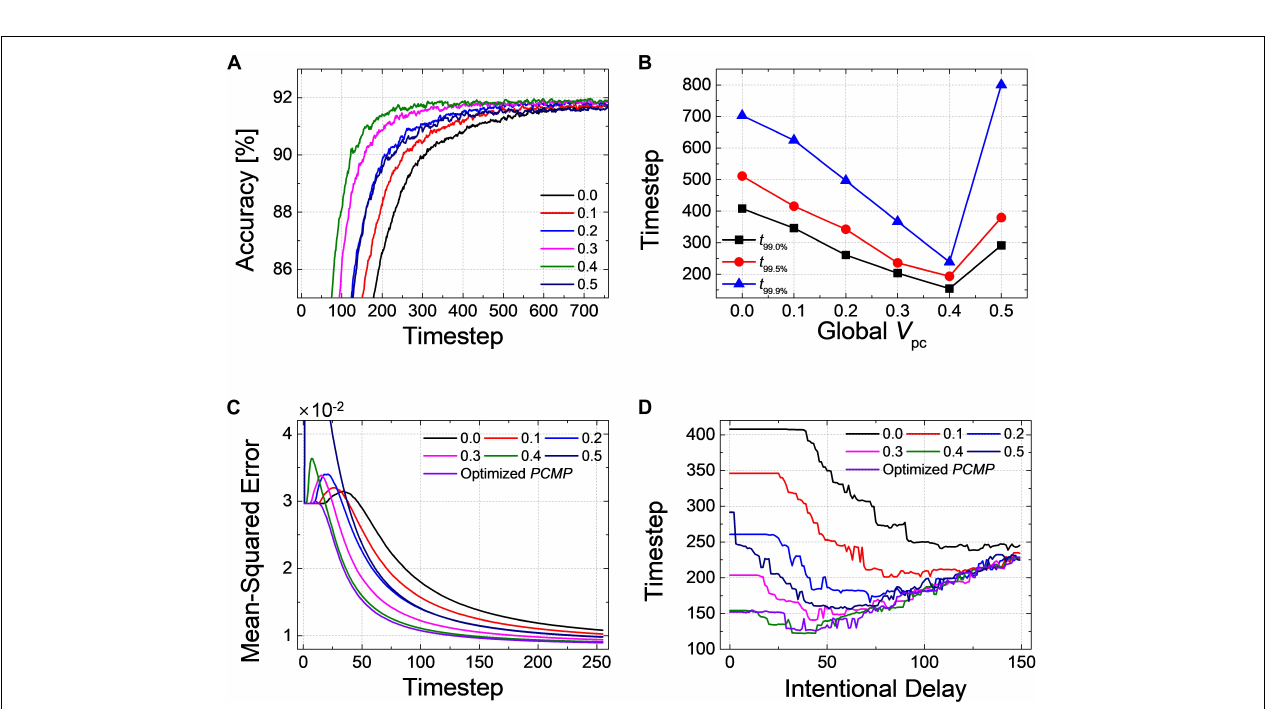
FIGURE 12 | Effects of the proposed methods on ResNet-20 . (A) Changes of the classification accuracy according to the global V pc from 0.0 to 0.5. (B) Extracted timesteps ( t 99 . 0% , t 99 . 0% , and t 99 . 9% ) with respect to the amount of the global V pc . (C) Changes of MSE for when increasing the amount of the global V pc from 0.0 to 0.5 with 0.1 steps and the optimized PCMP . (D) Changes of timestep when 99.0% of the ANN’s accuracy is reached when using DE .